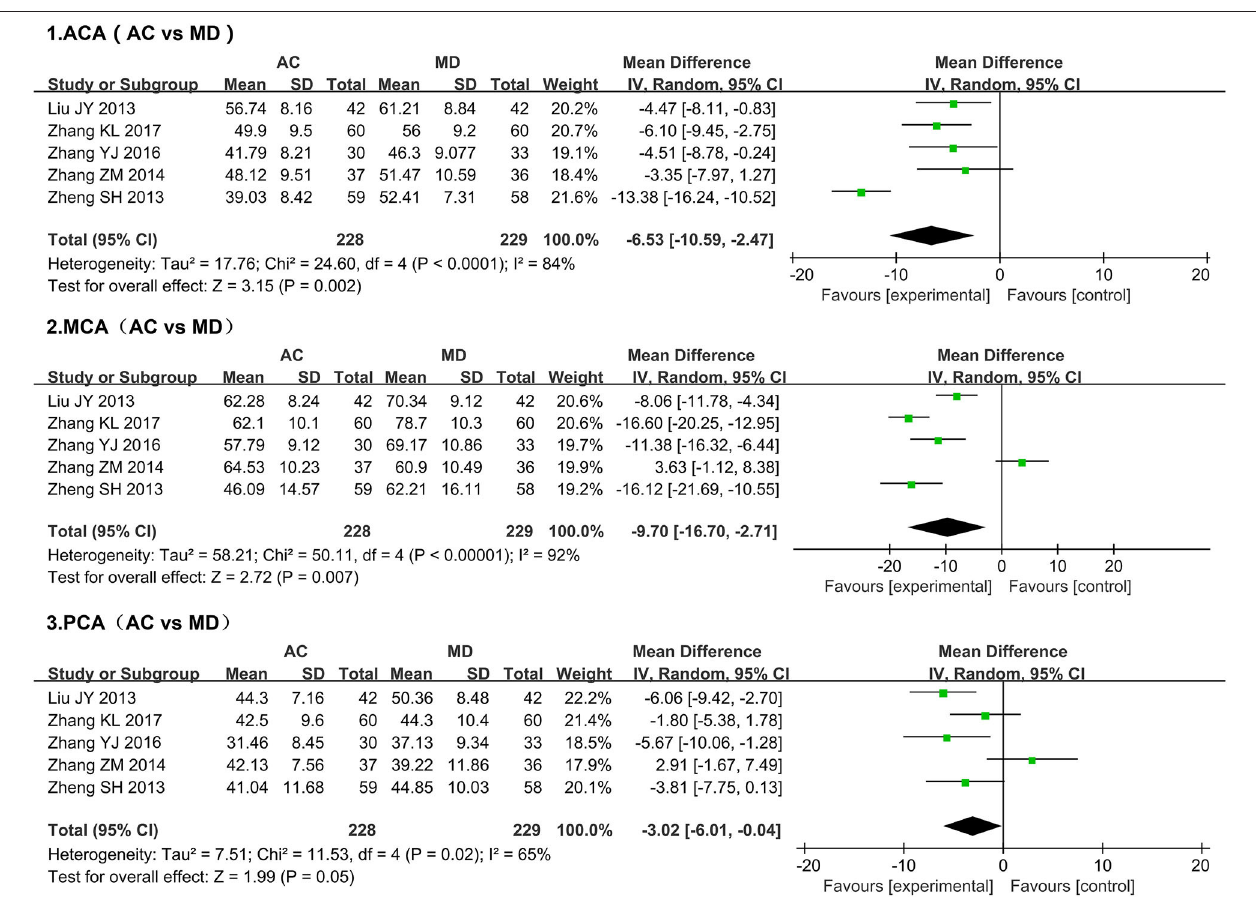
FIGURE 4 | Forest plots of TCD changes after acupuncture